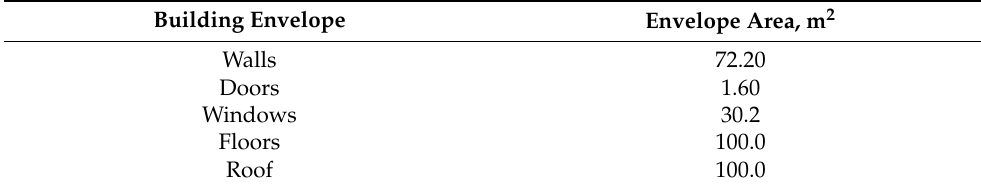
Table 4. Envelope areas of the modeled